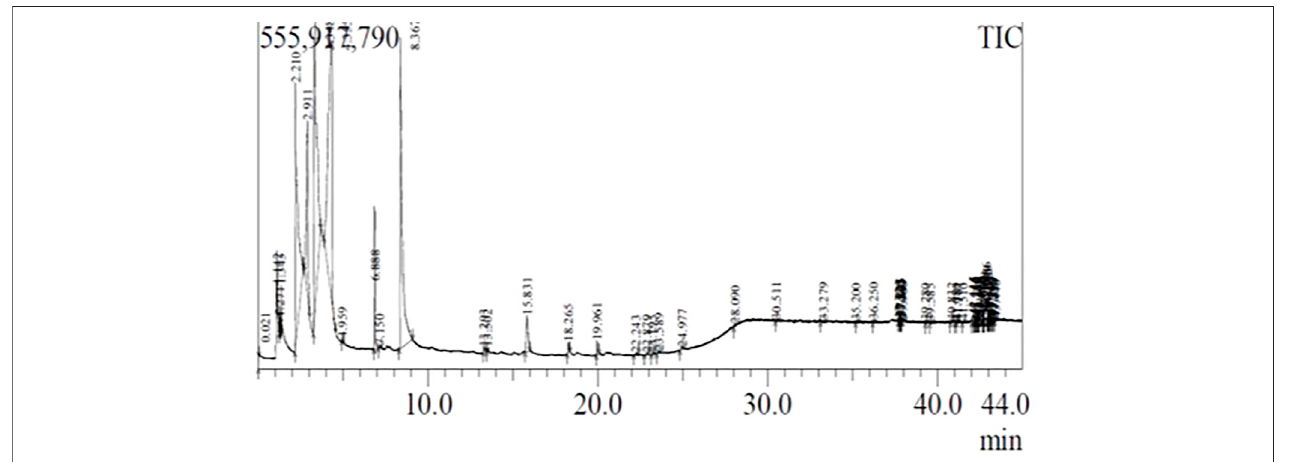
FIGURE 10 | GC-MS characterization of biodiesel from